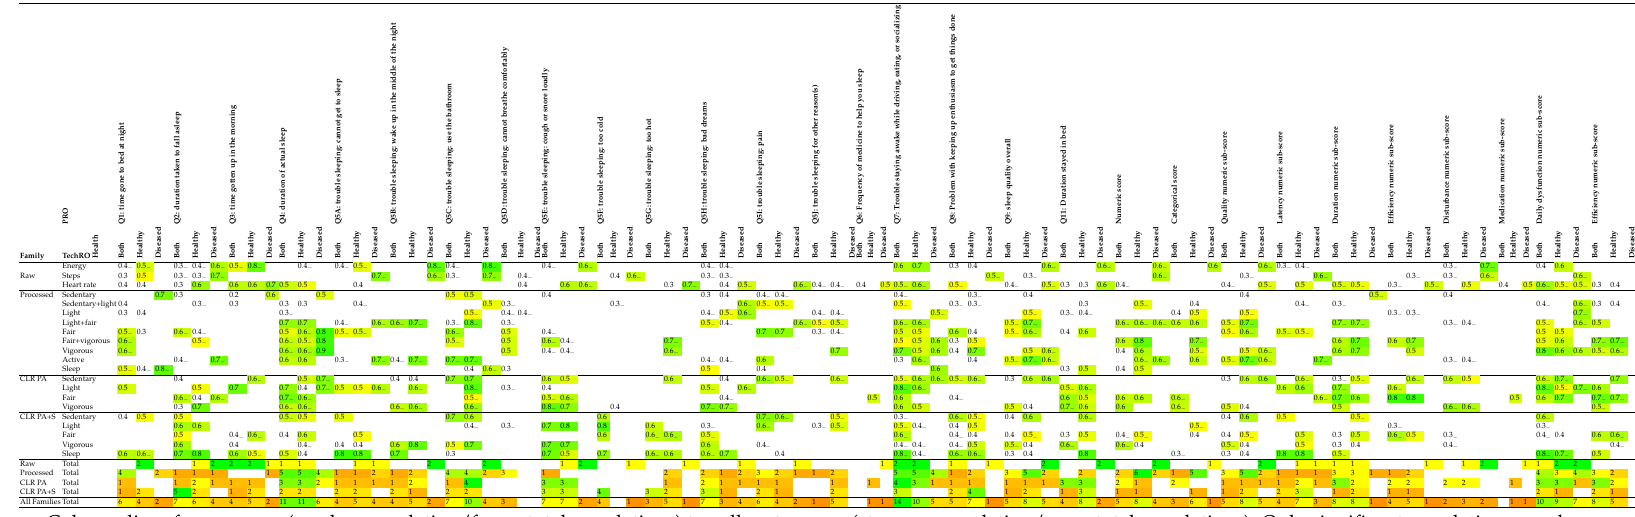
Color coding: from orange (weaker correlation/fewer total correlations) to yellow to green (stronger correlation/more total correlations). Only significant correlations are shown. Only coefficients of 0.5 or above are